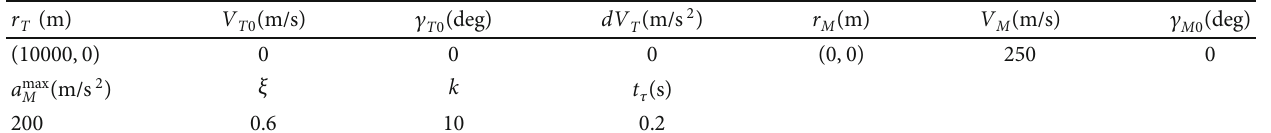
Table 2: Simulation conditions for Case I.